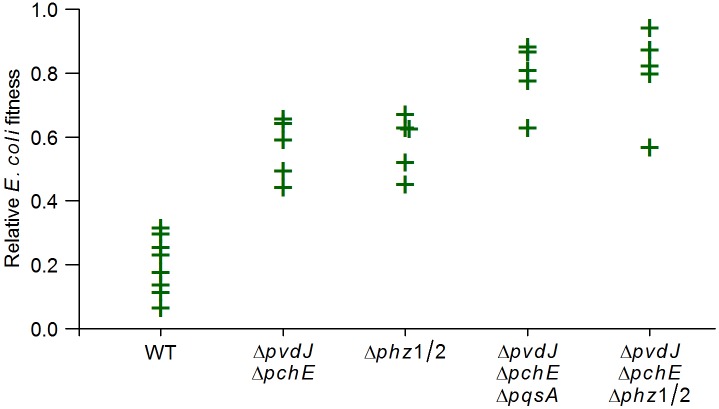

Pseudomonas siderophores and phenazines reduce fitness of E. coli in direct competition with P. aeruginosa.
E. coli cells were grown in direct competition with P. aeruginosa WT and mutant strains, and the fitness of both species was measured over a period of 20 hours. All mutant data were significantly different from WT (q < 0.001) as determined by a one-sided Mann-Whitney U test followed by the Benjamini-Hochberg procedure for multiple testing correction. The fitness of the mutant strains in competition with E. coli was similar to that of WT P. aeruginosa, supporting the idea that the siderophores and phenazines actively decrease E. coli fitness, rather than increasing P. aeruginosa fitness under our conditions.